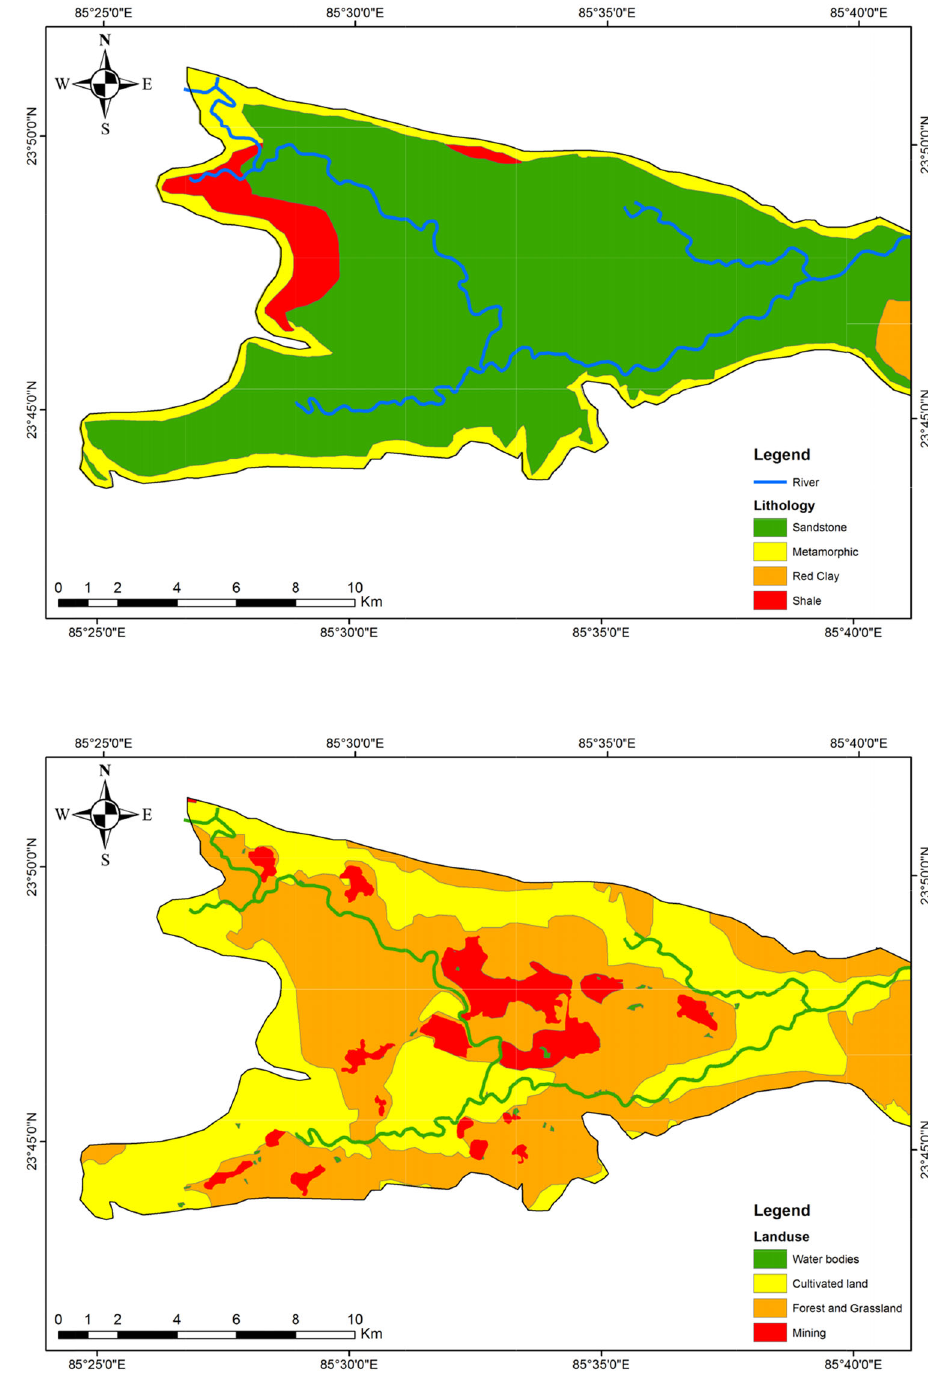
Fig. 7 Lithology class map of